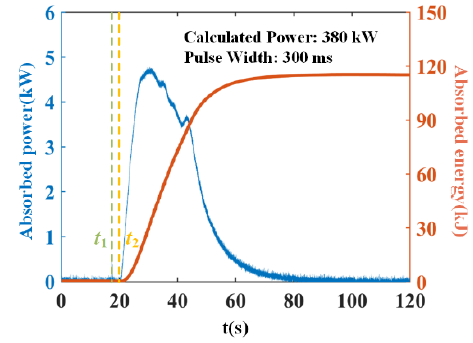
Fig. 7. A typical temperature rise curve during gyrotron operation, the left axis represents the power absorbed by water and the right axis represents the absorbed energy. Calculated power is 380 kW and the pulse width is 300 ms. t 1 is the microwave injection time while t 2 is the temperature rising time.